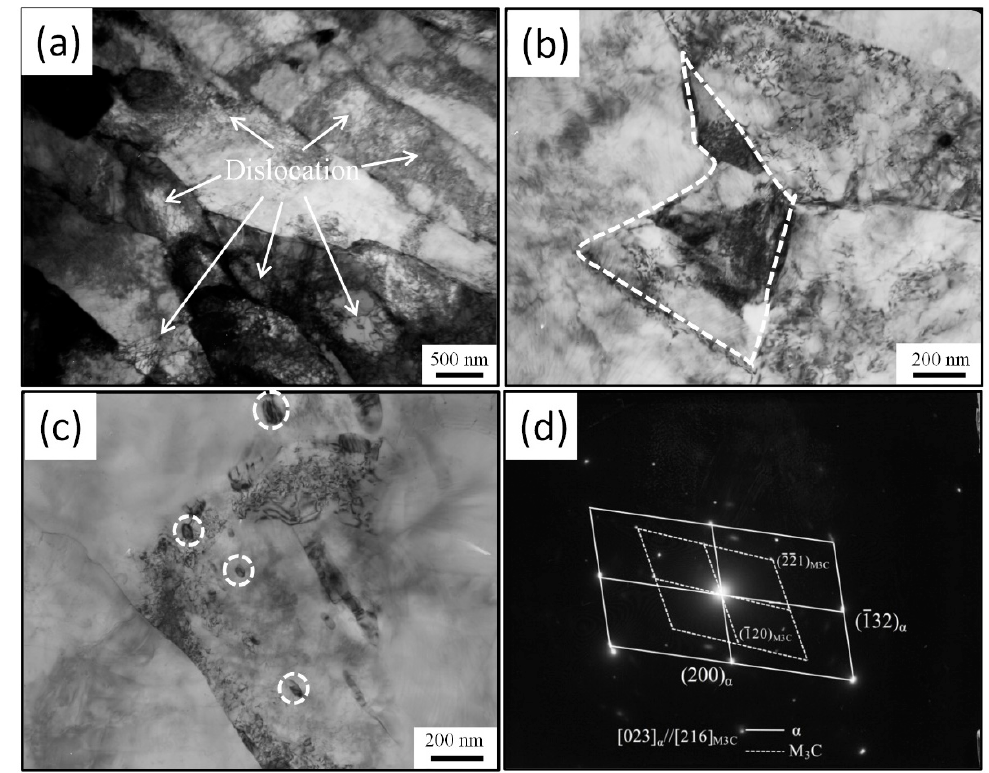
Figure 3. TEM images of the microstructure of Nb-Mo steel: ( a ) ferrite lath of granular bainite and dislocation in it and ( b ) an M/A island in rolled samples, ( c ) cementite in 600 °C tensile specimen and ( d ) the corresponding diffraction spot of particles in ( c ).